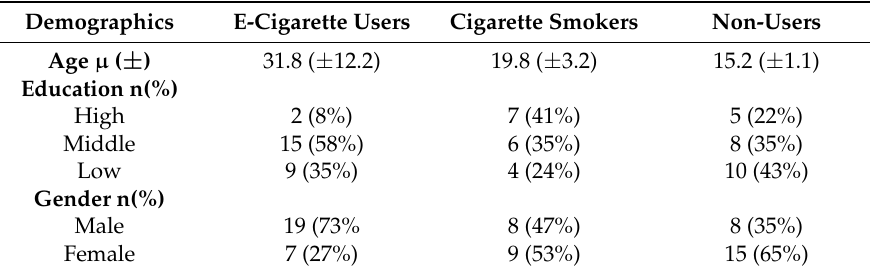
Table 1. Demographic information of the study